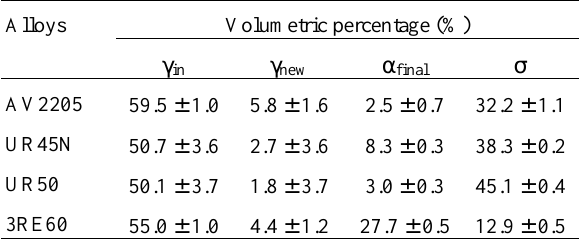
Table 4. The volumetric percentages of γ in , γ new , α final and σ phases in the alloys heat-treated for 5 h .